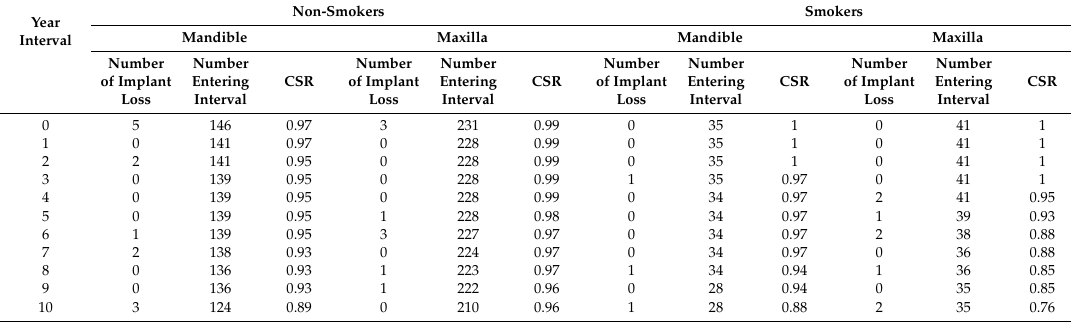
Table 3. Life table showing a summary of failures and the overall cumulative survival rate (CSR) in non-smokers and smokers with respect to the jaw (on the implant